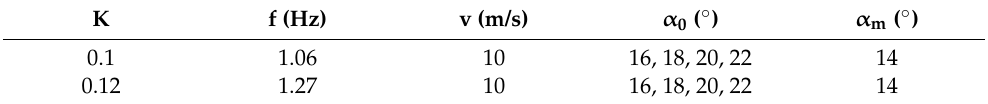
Table 6. Experimental conditions of changing the mean angle of pitch at different reduced